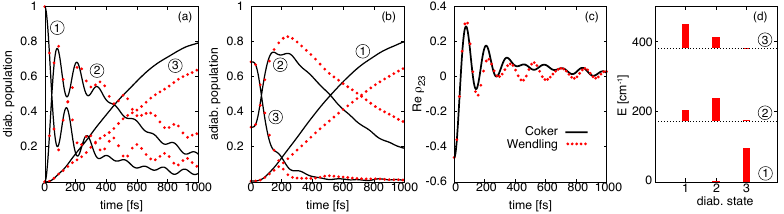
Simulation results are shown for the three-site ( ! = 1 − 3 ) FMO model as described in [10] using the Heidelberg MCTDH package [11]. Two different SDs will be compared, i.e. the discretized experimental Wendling SD [6], which is uniform for all sites, and the calculated site-specific Coker SD [7]. In the following we will discuss the one-exciton reduced density matrix in diabatic (site) representation, ! "# $ = Ψ($) ) * Ψ($) , as well as in the adiabatic (eigenstate), ! "# $ , representation. The eigenstates are defined as ! = # $ ! % $ , the squared coefficients for the used excitonic model Hamiltonian are shown in Fig. 1(d). Apparently, sites 1 and 2 are strongly coupled, whereas site 3 is only weakly mixed with site 2. The diabatic population dynamics upon initial excitation of site 1 is shown in Fig. 1(a) for the Wendling and Coker SDs. First, we notice that the overall behavior is rather similar to previous reduced density matrix calculations [3,4], i.e. there is a beating between sites 1 and 2, which is damped on the time scale of about 1 ps, along with a decay into site 3 whose dynamics doesn’t show any oscillations. We emphasize, however, that the decay is solely an effect of the high-dimensional vibrational space and not the result of phenomenologically introduced rates. The adiabatic population dynamics in Fig. 1(b) doesn’t show the rapid oscillations and merely reflects the decay of the initial exciton eigenstate populations. The Wendling and Coker SDs differ in shape as well as in the integrated Huang-Rhys factor (Wendling: 0.42, Coker: (0.64,0.96,0.58) for sites (1,2,3)). In [10], it was argued that the total Huang-Rhys factor determines the effective decays rates, whereas vibrational and vibronic excitation are sensitive towards the actual shape of the SD. The dependence of the population and also the coherence decay on the SD model is confirmed by Fig. 1(a-c). A more global view on the dynamics is provided by the time-averaged exciton density matrix in diabatic representation, ! "# $ = & '( )* ! "# (*) $ . In Figs. 2(b) and -